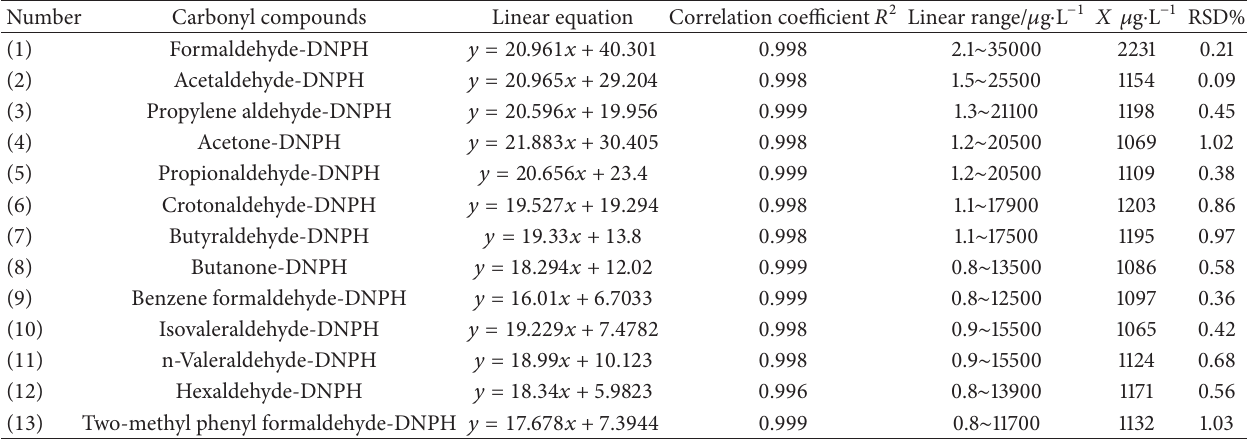
Table 4: The linear equation, correlation coefficient, and linear range of the 13 kinds of